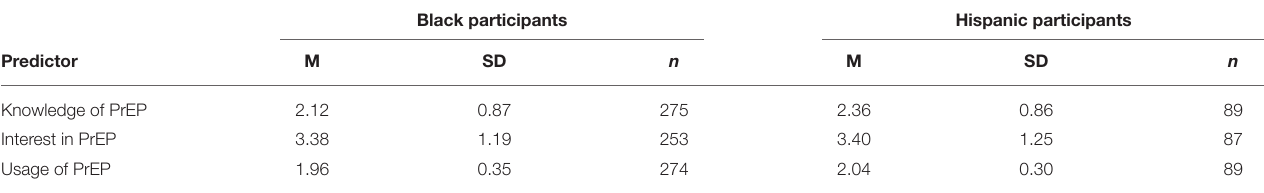
TABLE 3 | Means and standard deviations for the predictors by race/ethnicity.